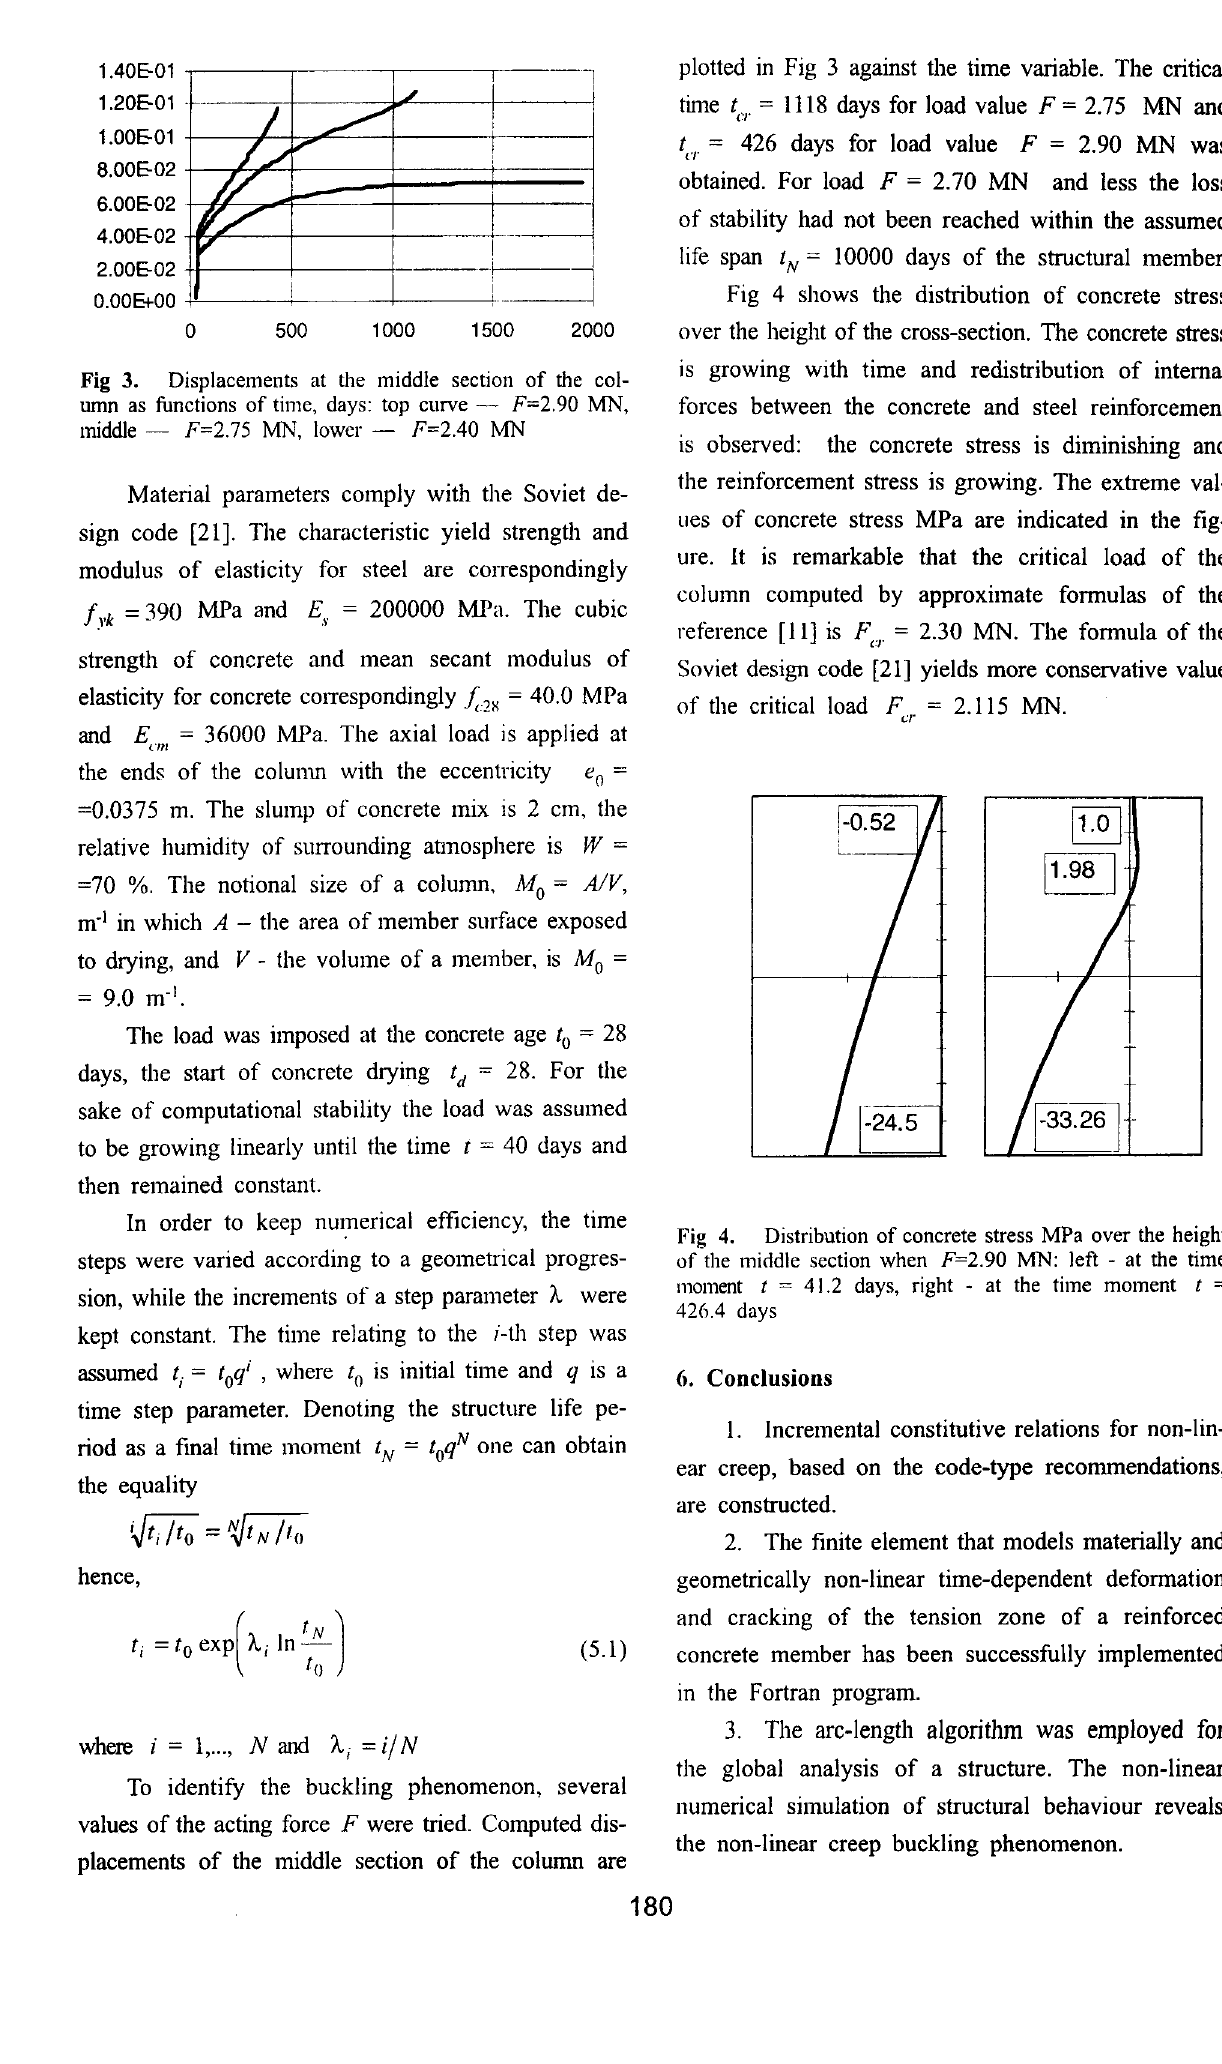
Fig 3. Displacements at the middle section of the col umn as functions of time, days: top curve- F=2.90 MN, middle - F=2.75 MN, lower - F=2.40 MN